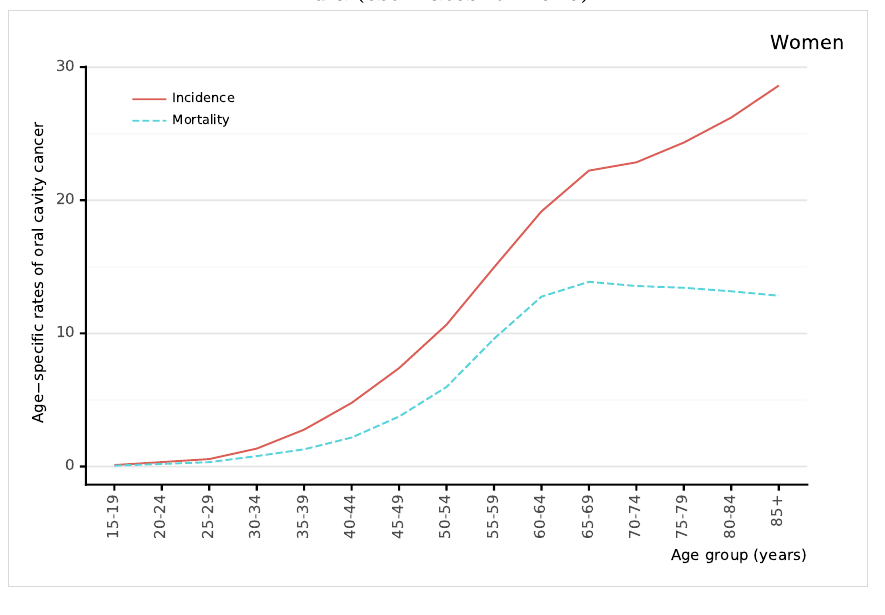
Figure 47: Comparison of age-specific oral cavity cancer incidence and mortality rates among women